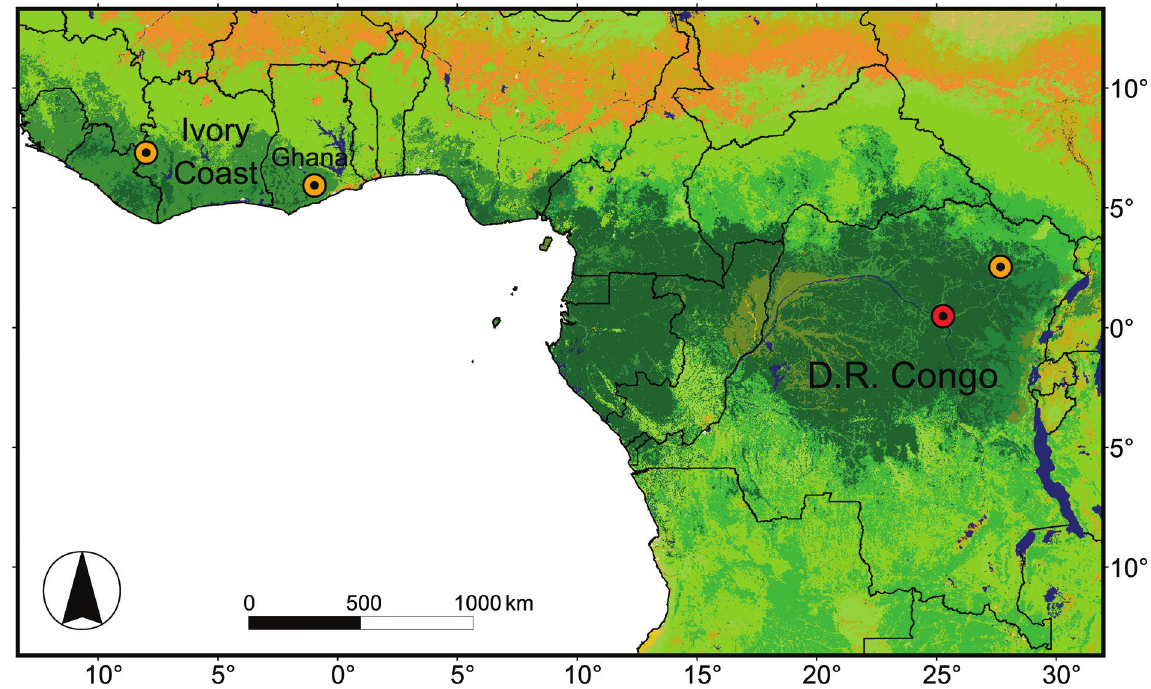
Fig. 7. Distribution map of G. superba showing the four currently known records from Ivory Coast, Ghana, and DRC; red dot: Mbiye Island. Land cover data from GLC2000 (Mayaux et al. 2004).